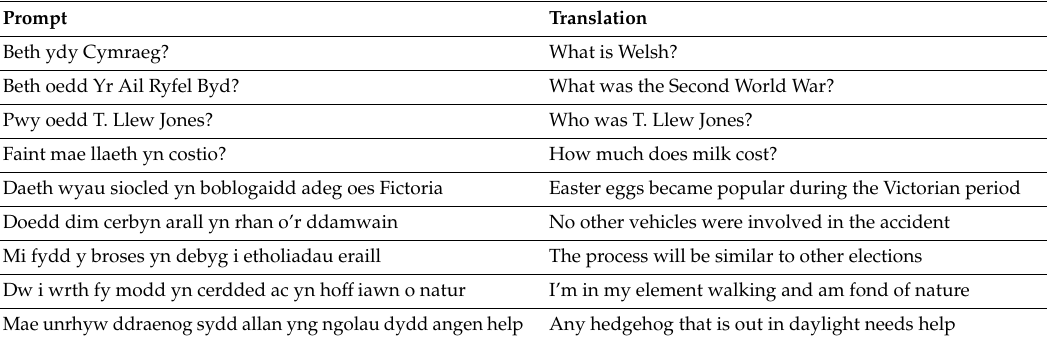
Table 2. Examples of full question / sentence prompts with English translations.